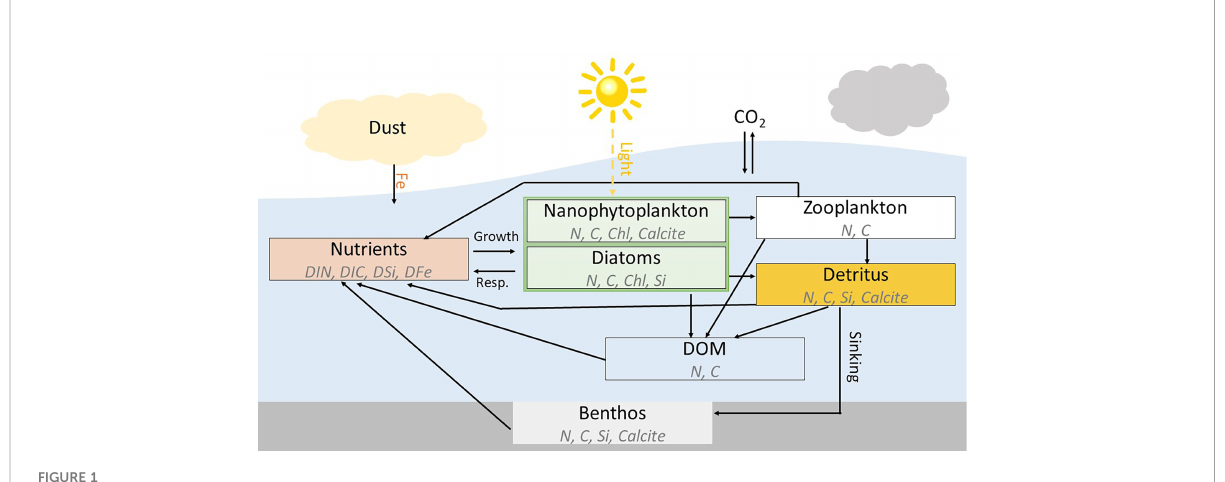
FIGURE 1 Schematic diagram of the ocean BGC model